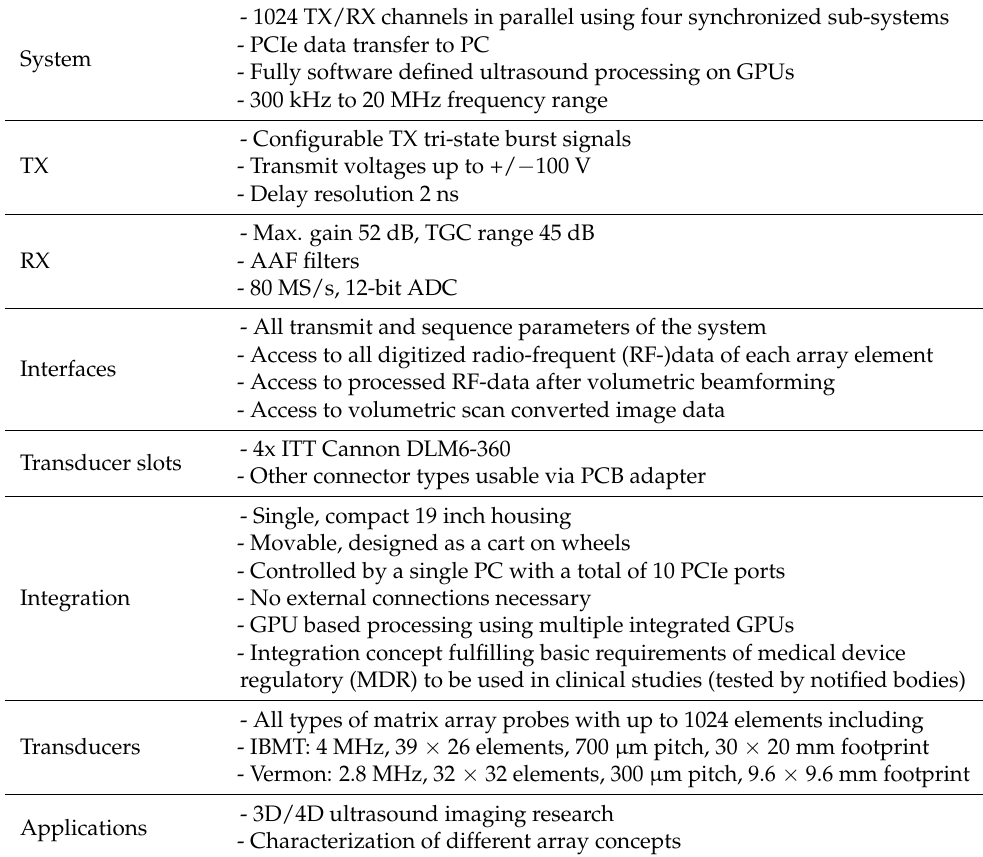
Table 1. Features of the 1024-channel DiPhAS 1